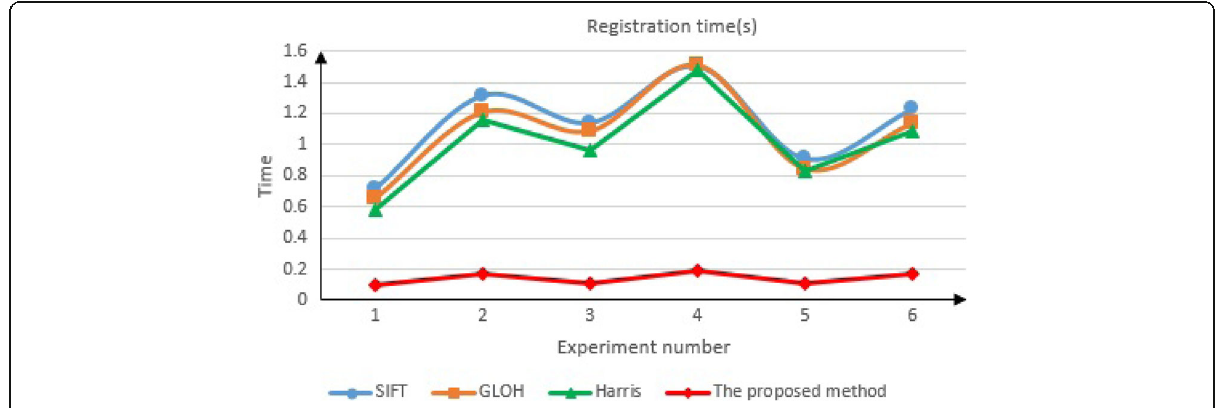
Fig. 8 The curve of registration time comparison with some